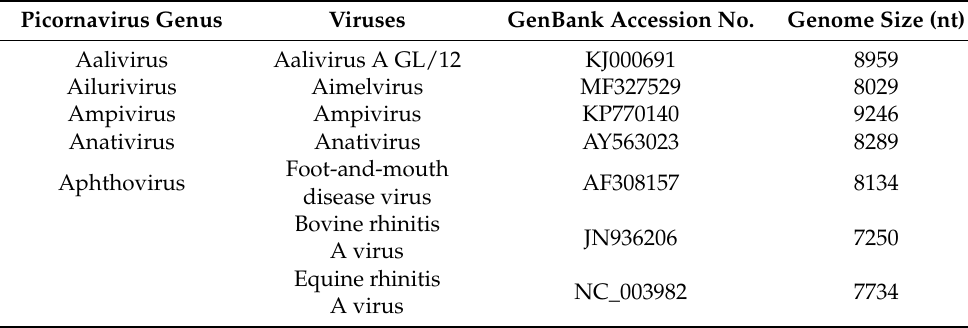
Table A1. The list of some representative viruses in the picornavirus family. Picornavirus